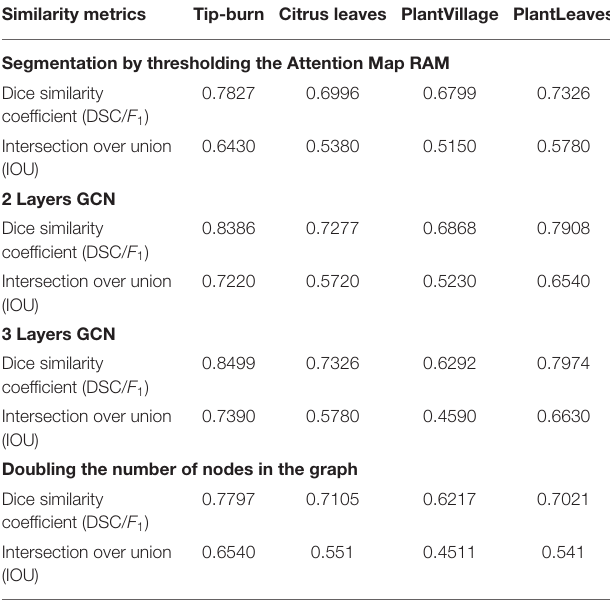
TABLE 2 | Segmentation and